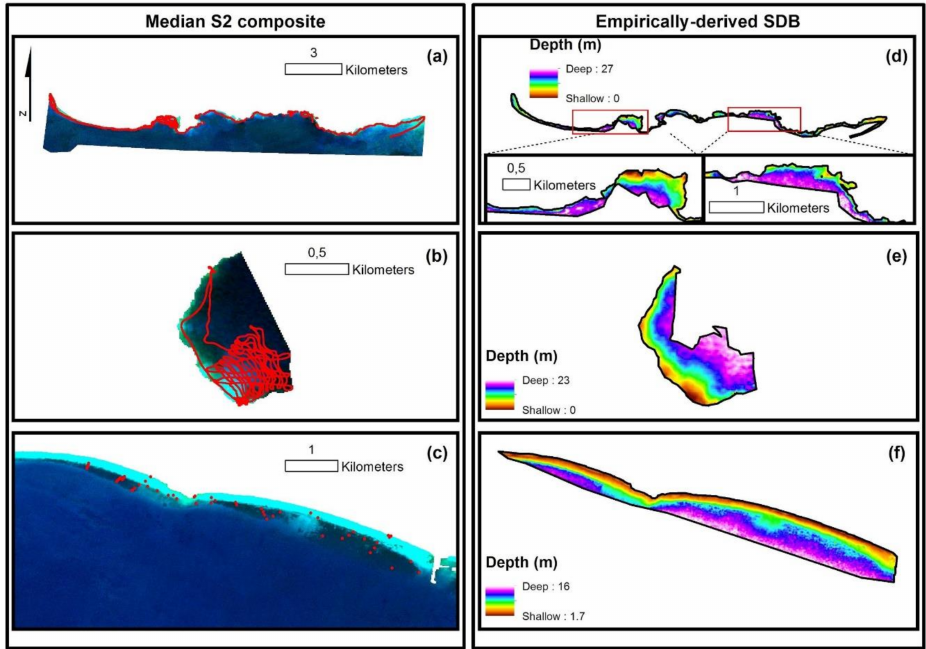
Figure 4. Pre-processed median Sentinel-2 composites using the workflow of Figure 2 on the left panels ( a – c ) and related best empirical satellite-derived bathymetry (SDB) estimates on the right ( d – f ): The National Samaria Park composite and related SDB estimates in panels ( a , d ); Apokoronas composite and related SDB estimates in panels ( b , e ); Thermaikos composite and related SDB estimates in panels ( c , f ). Red points depict the employed in situ points in the training ( a ) and validation ( b , c ) of the SDB models here. Best algorithm (highest R 2 , lowest RMSE) in all three cases is Lyzenga85 model applied on 3 × 3 smoothed and normalised median Sentinel-2 composites using the shown pseudo-invariant (PIF) features in the zoomed maps of Figure